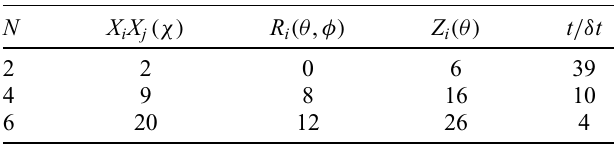
TABLE I. Gate counts for simulating each Trotter step of the time evolution in the Schwinger model with the odd-even term ordering in Eq. (11), along with the largest number of Trot- ter steps t /δ t implemented in the experiment for N = 2, 4, 6 staggered